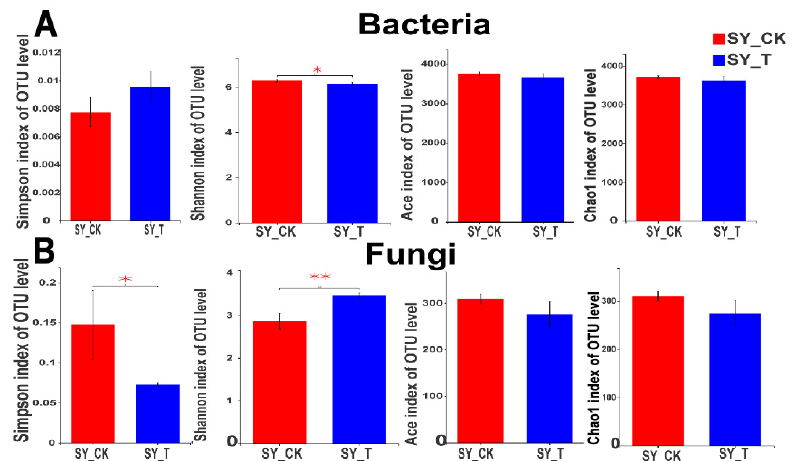
Figure 3. Chao1, ACE, Shannon and Simpson indices showing taxonomic changes in ( A ) bacteria and ( B ) fungi in triple-fumigated soil that had been used to produce cucumber. ‘Triple fumigation’ refers to the simultaneous application of chloropicrin, dimethyl disulfide and metham sodium. The t -test reported the statistical differences (asterisked, * 0.01 < p ≤ 0.05; ** 0.001 < p ≤ 0.01.) between the means of three replicates within each graph.